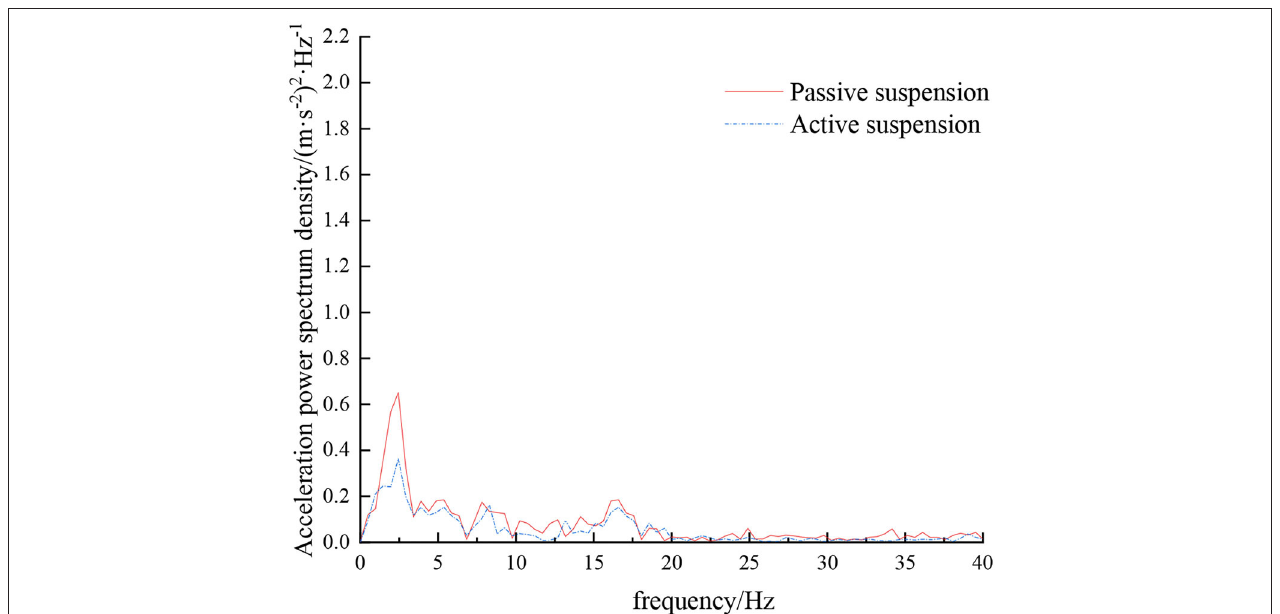
FIGURE 14 | Frequency domain response curve when driving at 5km/h on sand-gravel